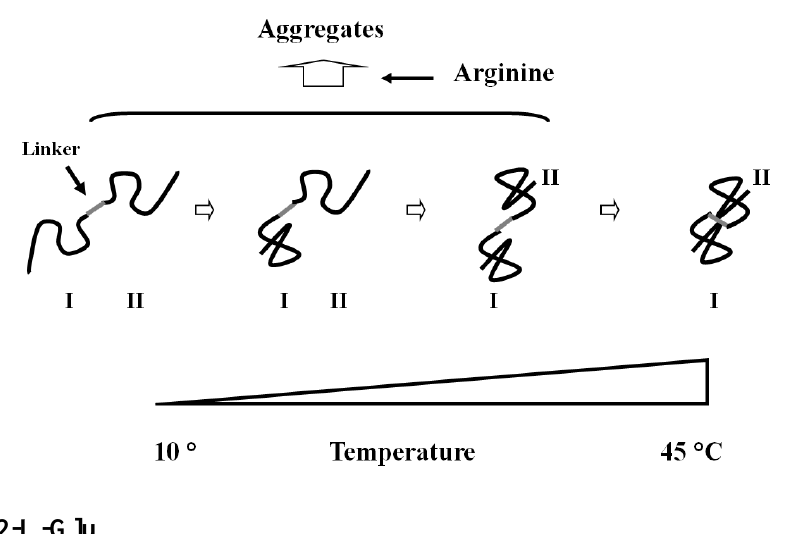
Figure 11. Schematic illustration of folding course of scFv. Two black curves express two variable domains (I and II). Gray line is a linker connecting two